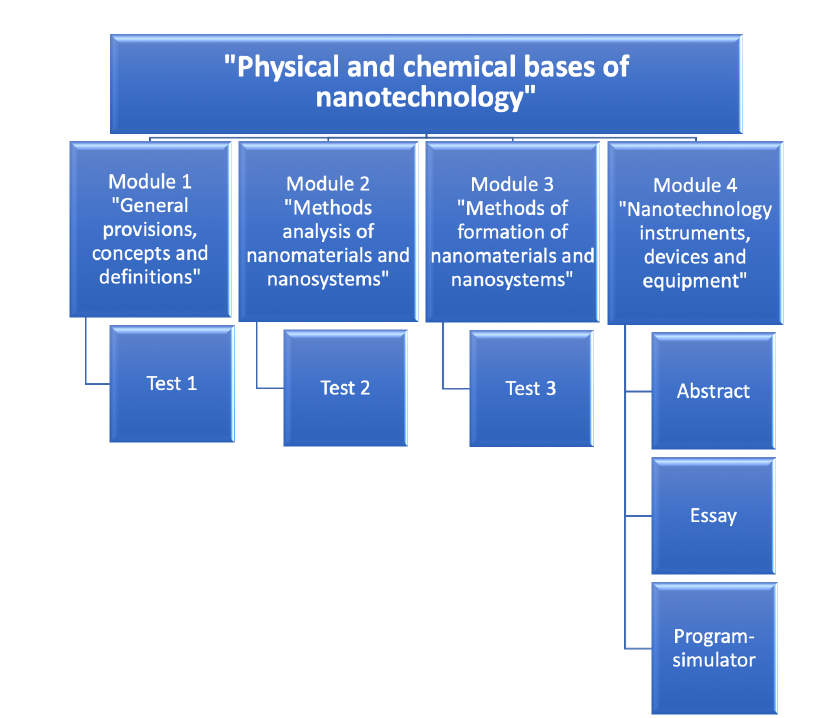
Fig. 1. The structure of the course «Physical and chemical bases of nanotechnology» with the use of control